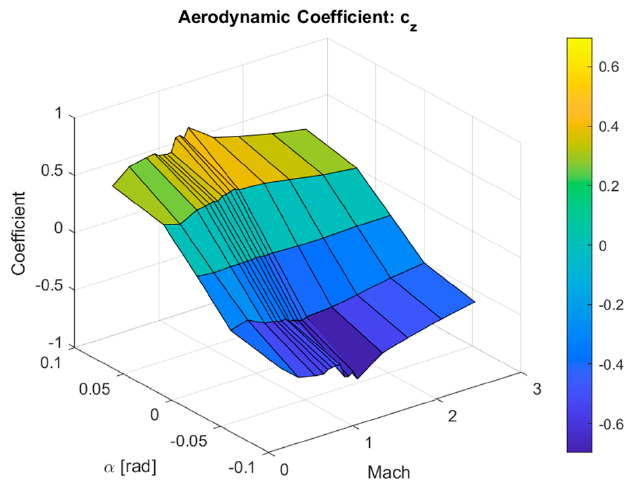
Figure 18. Normal force coefficient as derived from the angle of attack and Mach number.